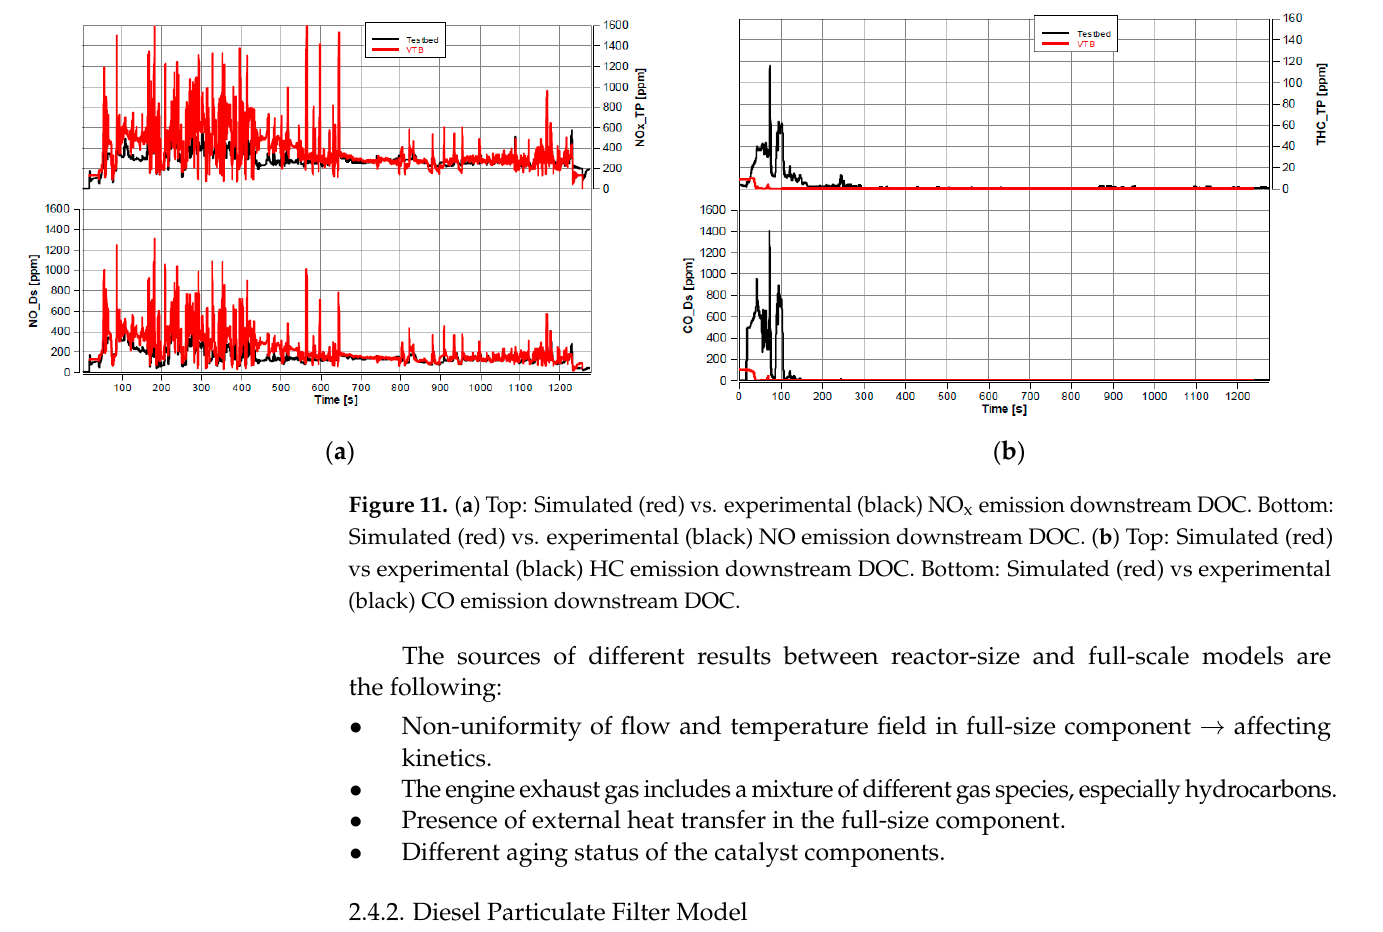
Figure 10. ( a ) Simulated (red) vs. experimental (black) NO x emission downstream DOC. ( b ) Simu- lated (red) vs. experimental (black) HC emission downstream DOC.